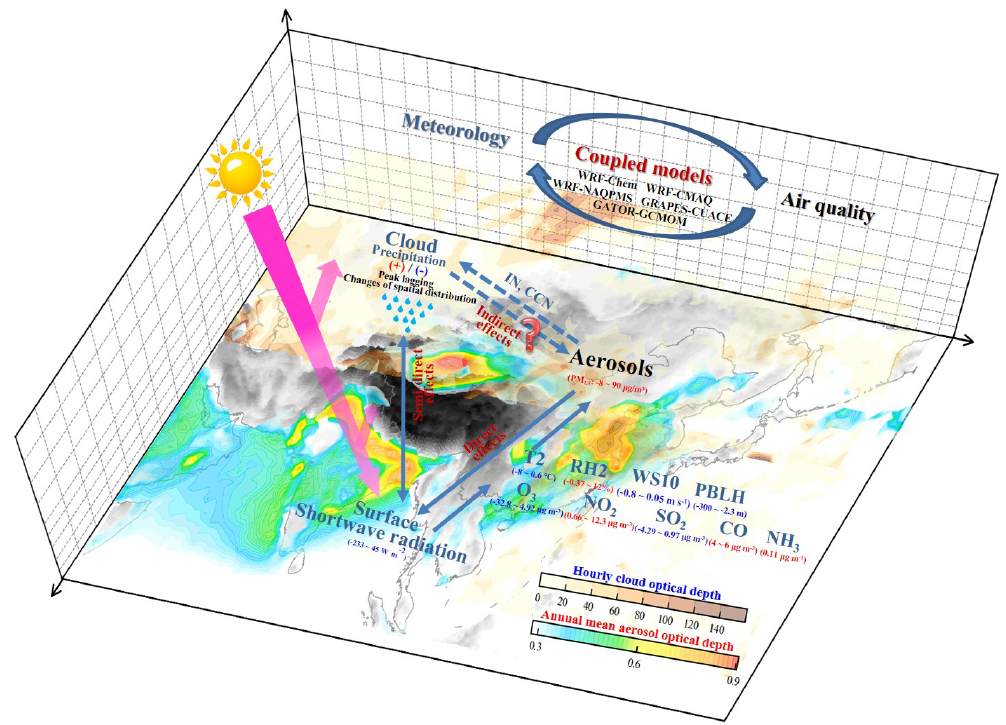
Figure 9. A schematic diagram depicting aerosol–radiation–cloud interactions and quantitative effects of aerosol feedbacks on meteorolog- ical and air quality variables simulated by two-way coupled models in